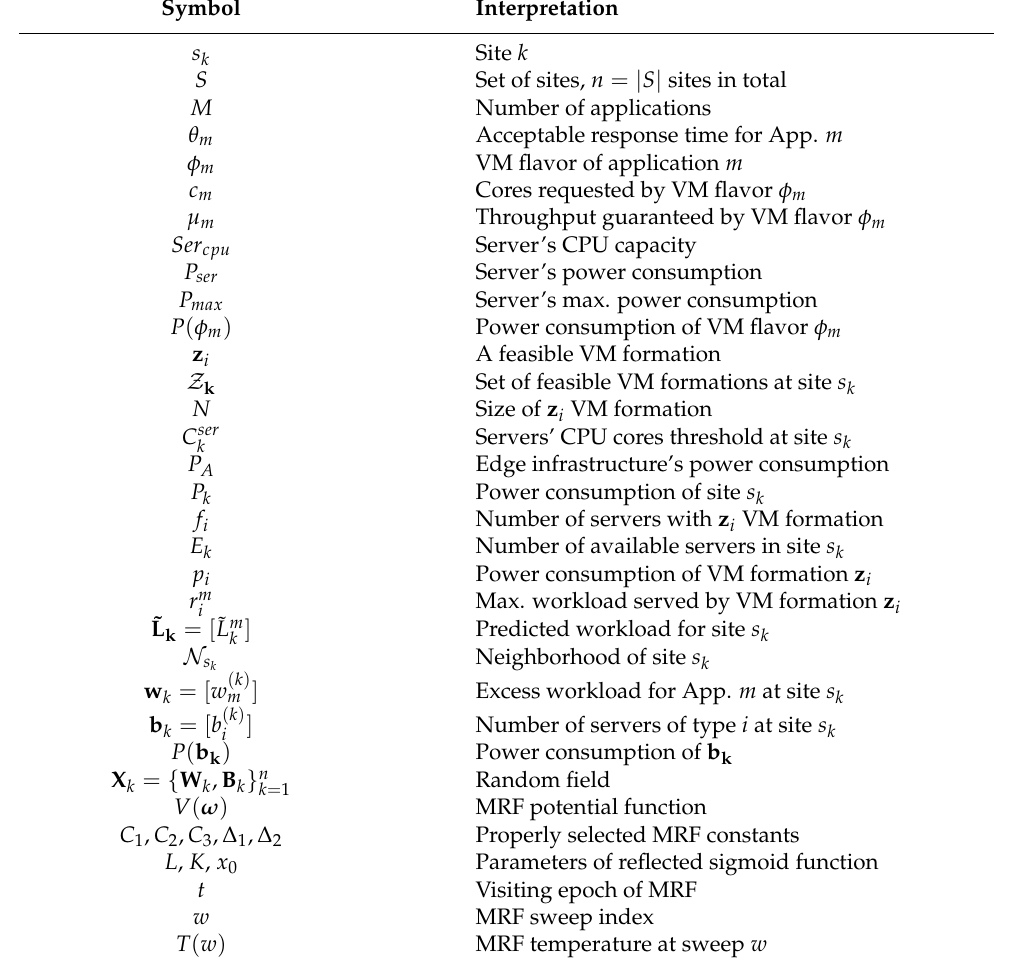
Table 1. Summary of the Key